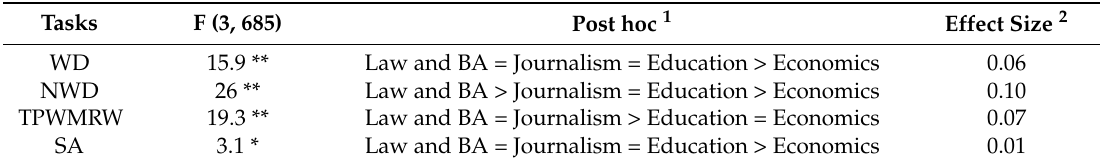
Table 2. ANOVA, Post hoc Results and Effect size by Field of